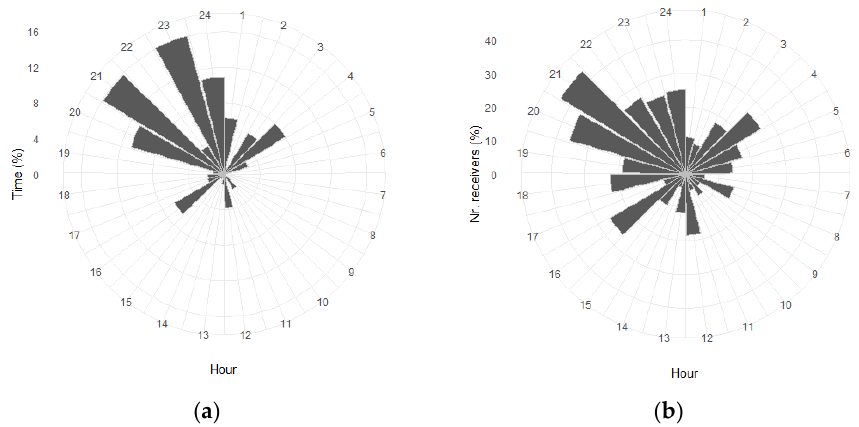
Figure 9. Circadian activity and movement patterns of dusky grouper G29 during the 25-day period of residency inside the Martinhal Islets no-take area: ( a ) Mean percentage of the total time in which G29 was continuously active per hour of the day; ( b ) Mean percentage of the total number of receivers with detections of G29 per hour of the day. At that time of the year, dusk periods occurred between 7:30–9:30 p.m. (UTC), while dawn periods occurred between 3:30–5:30 a.m. (UTC)